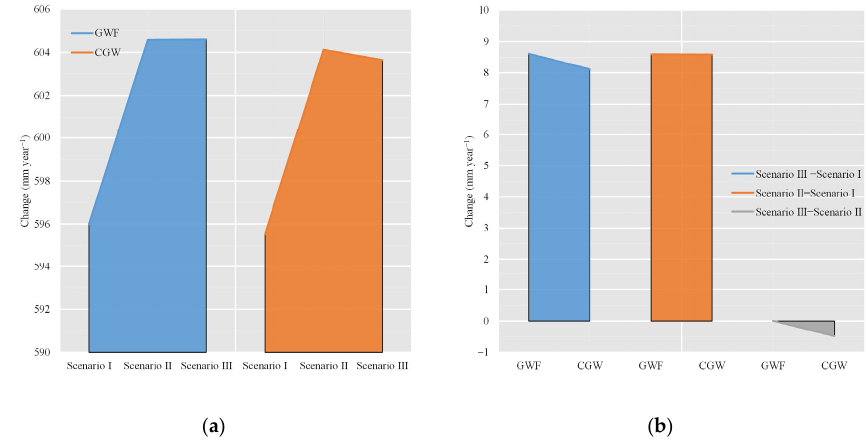
Figure 6. Simulation of the average annual values of green water flow (GWF) and its components (consumed green water, or CGW) ( a ) in the upper Ganjiang River basin due to climate change, land-use change, and the combined effects of all the above factors ( b ).